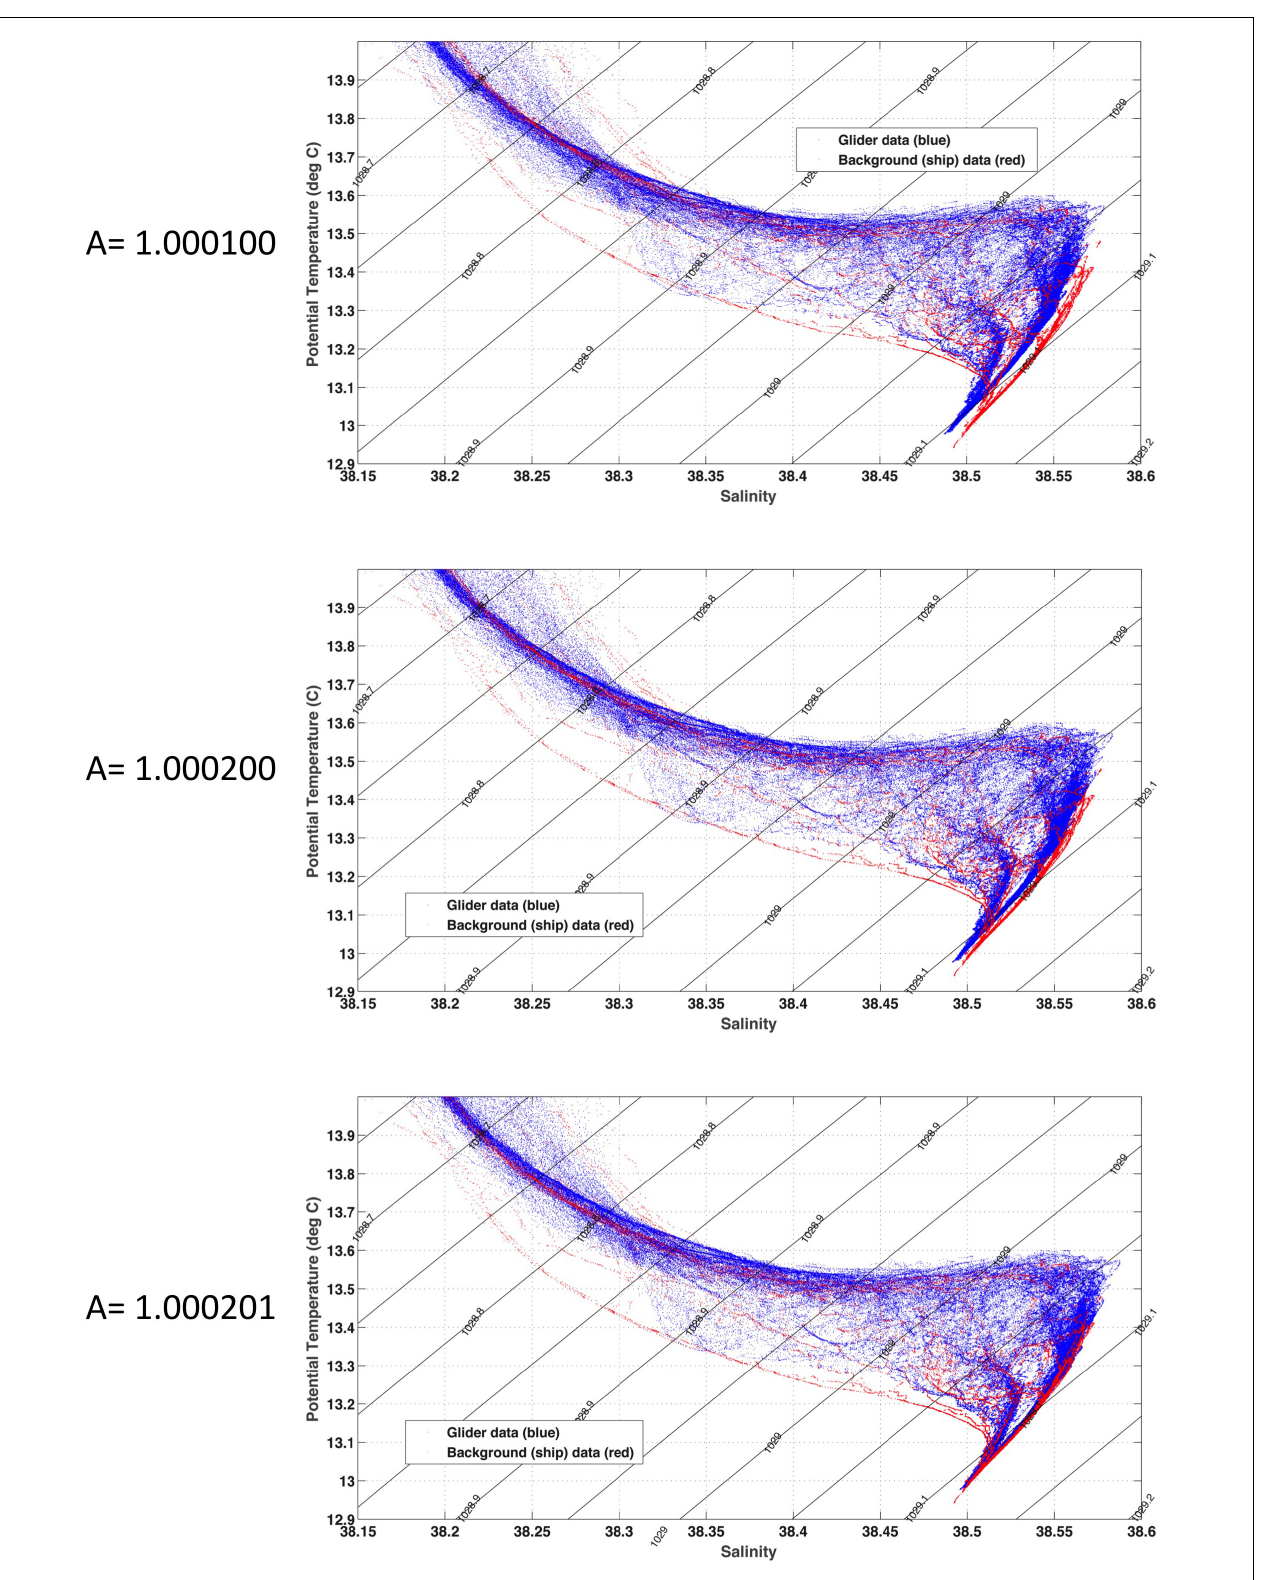
FIGURE 3 | The iterative selection of gradient A, when field correcting glider data to CTD stations.